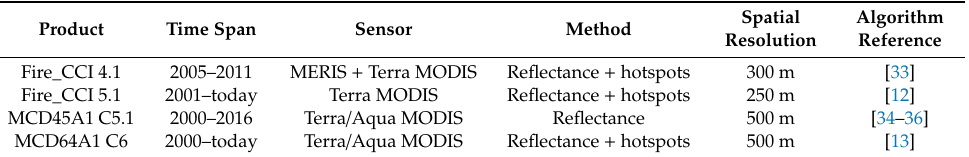
Table 1. Burned area products.